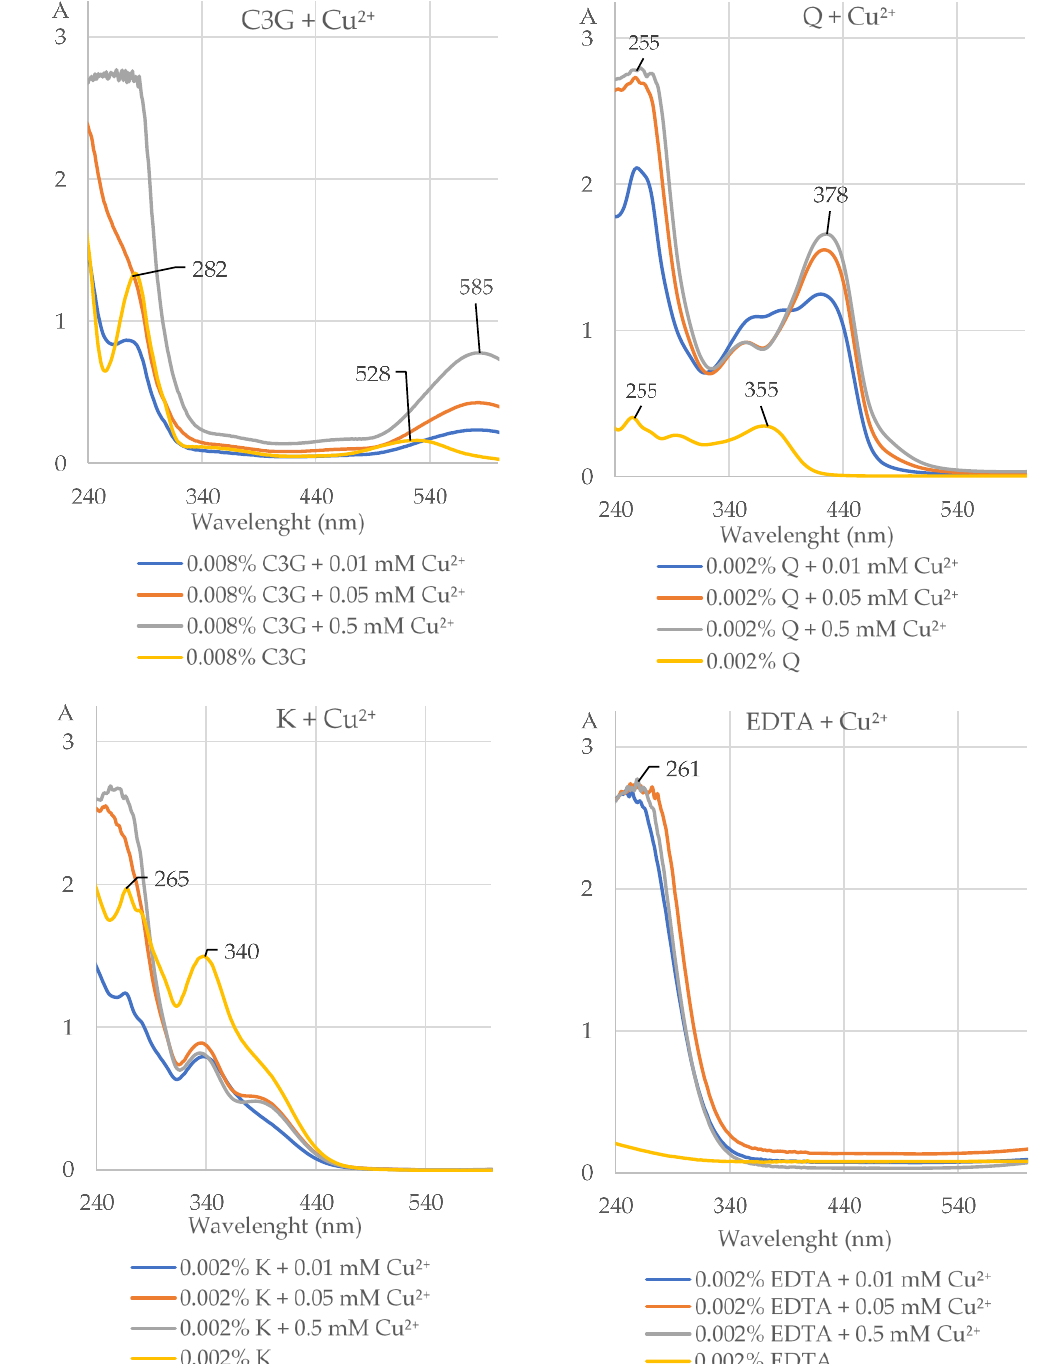
Figure 4. The UV–Vis absorption spectra (with indicated maximum absorption) of cyanidin 3- O - β -galactoside (0.008% C3G), quercetin (0.002% Q), kaempferol (0.002% K), and ethylenediaminetetraacetic acid (0.002% EDTA) alone and after addition of divalent ions of copper (Cu 2 + ) at the concentrations of 0.01, 0.05, and 5 mM at pH 5.5. The shift of the maximum absorption after addition of Cu 2 + to the solution of the investigated compound indicates that this compound chelated these ions. A, absorbance.